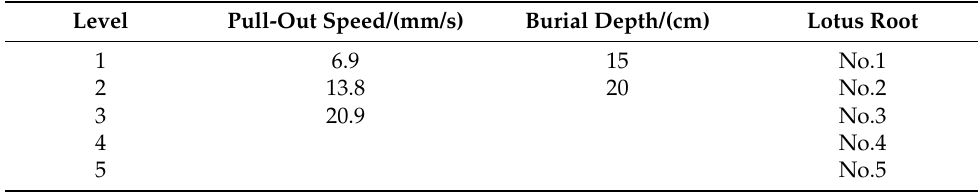
Table 4. Factors for the experiment.